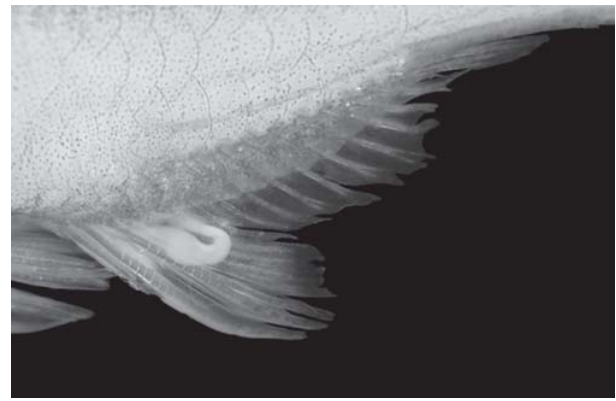
Fig. 2. Lateral view of the anal-fin organ in Bryconadenos weitzmani , paratype MZUSP 96559, 36.5 mm SL, male, anterior to